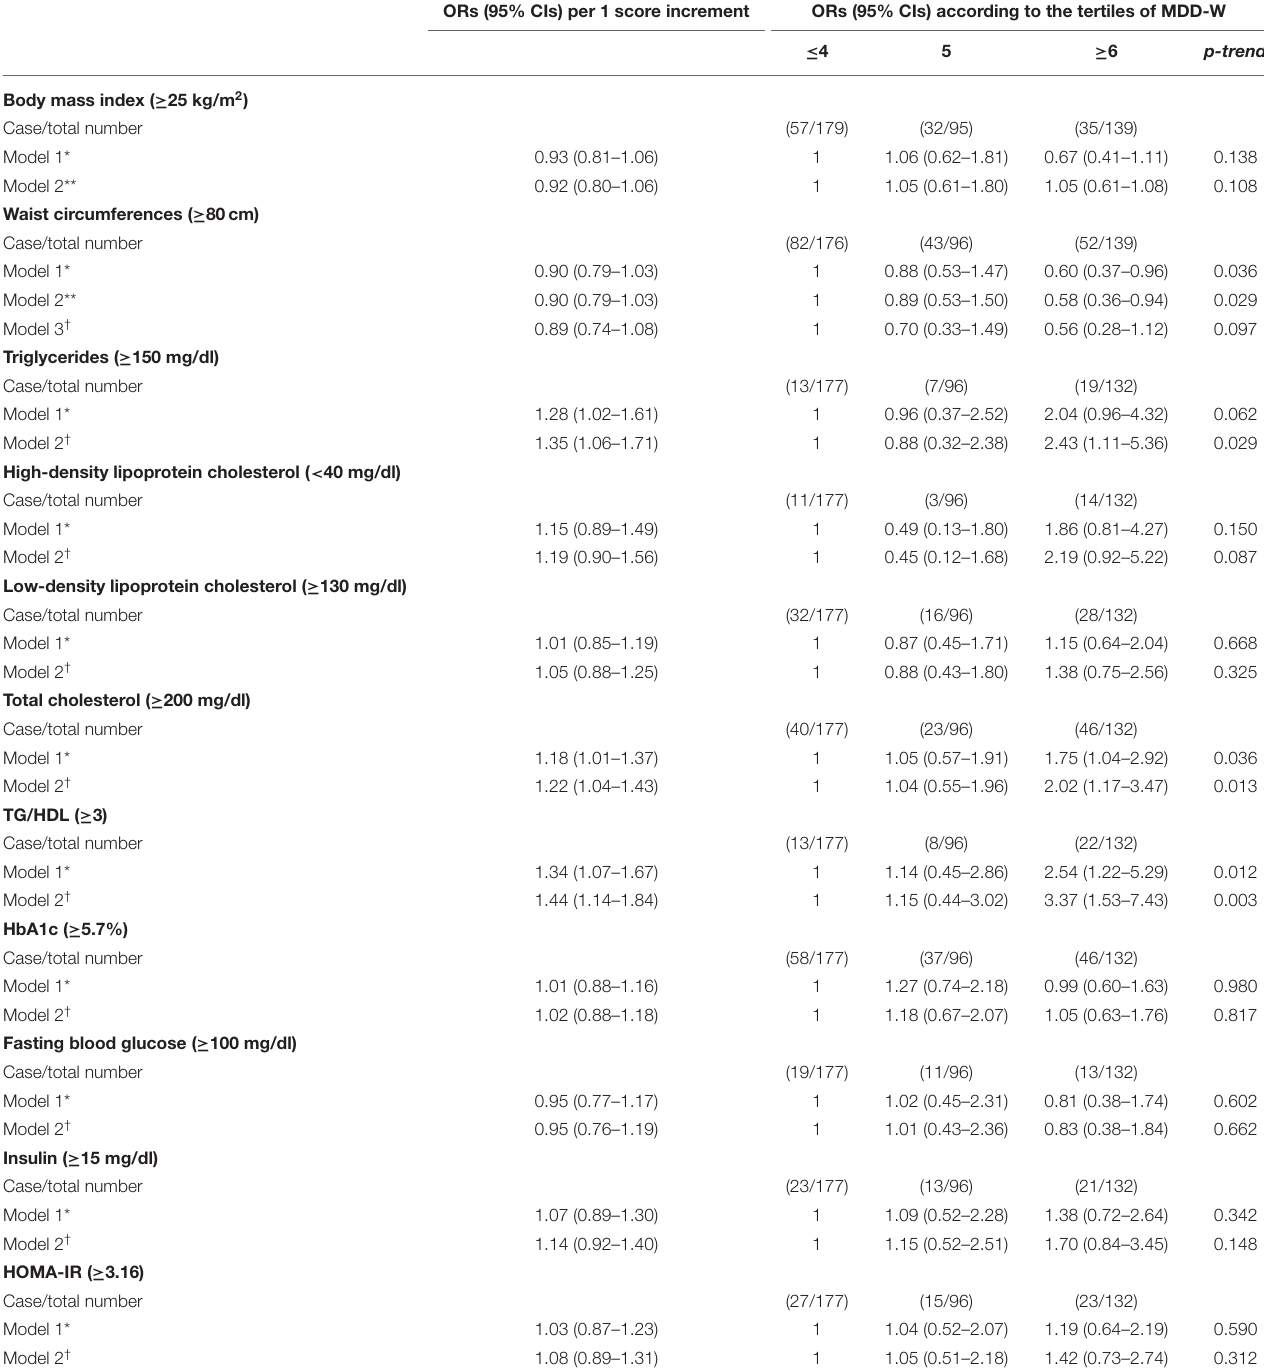
TABLE 3 | Odds ratios (ORs) and 95% confidence intervals (CIs) of BMI, waist circumferences, triglycerides, HDL-C, LDL-C, total cholesterol, TG/HDL, HbA1c, fasting blood glucose, insulin, and HOMA-IR, according to the MDD-W scoring in the FiLWHEL study. ORs (95% CIs) per 1 score increment ORs (95% CIs) according to the tertiles of